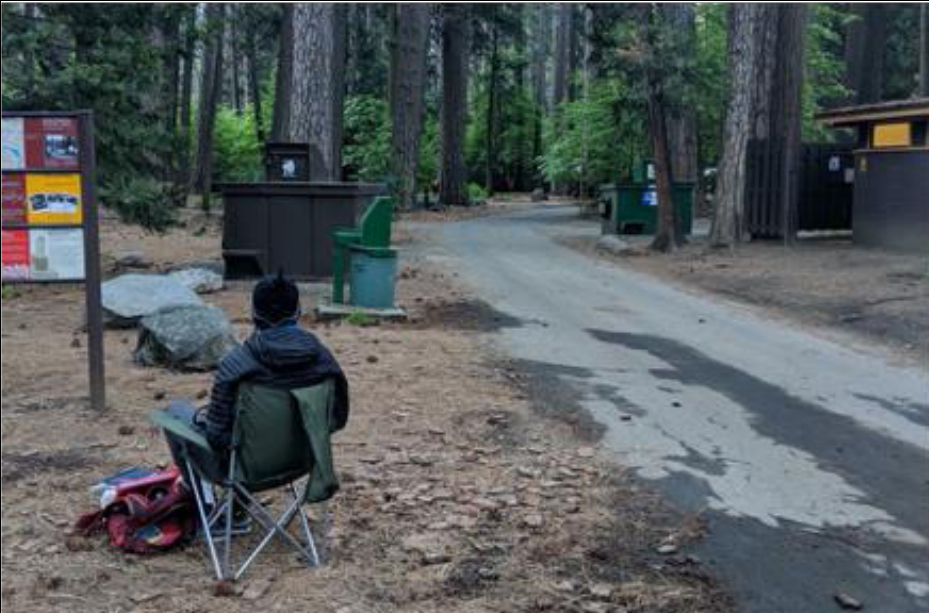
Figure 2. Unobtrusive observations of waste disposal behaviors in National Park campgrounds.